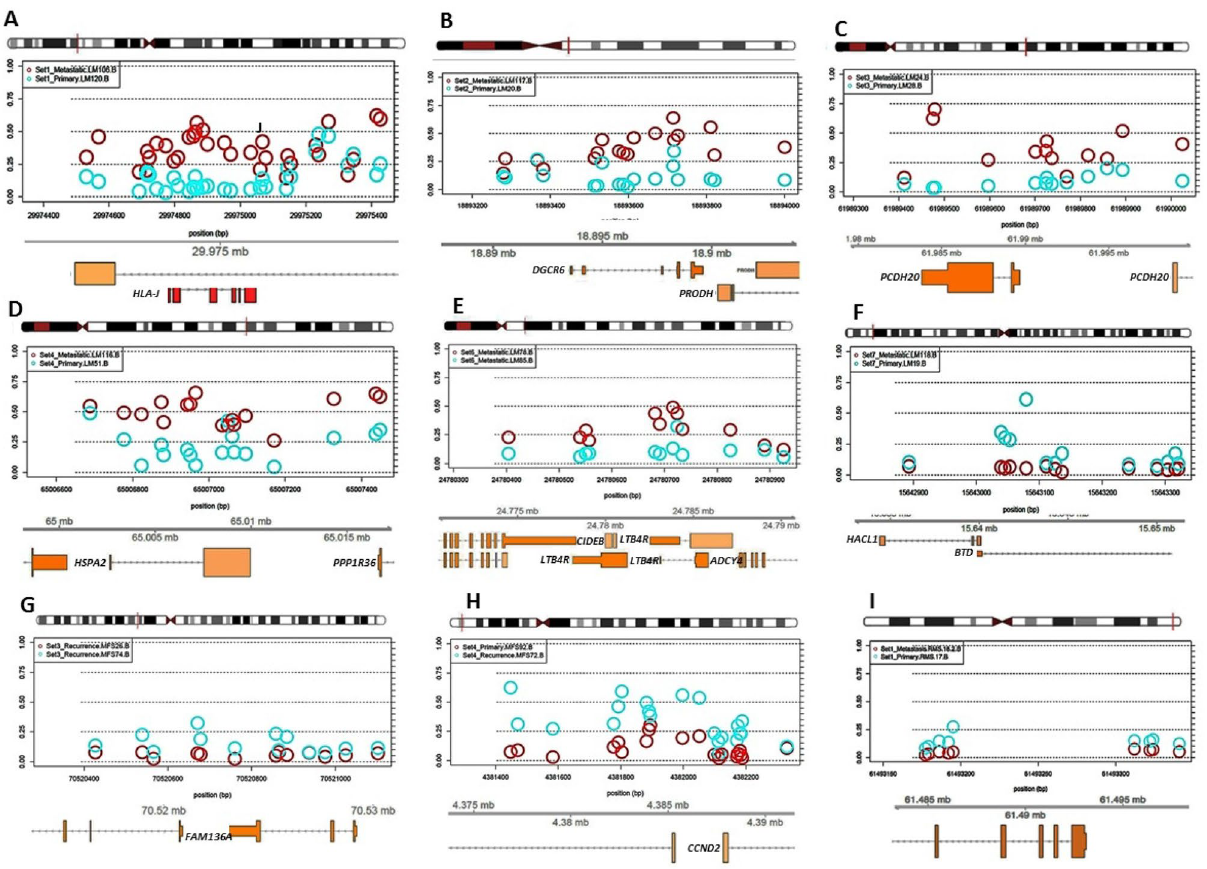
Figure 2. Beta values, probe distribution and genomic annotation for significant differentially methylated regions (DMRs) of selected paired samples. Leiomyosarcomas (LMS) sets 1 ( A : HLA-J in Chr 6 [897 bp region]), 2( B : DGRC6 & PRODH in Chr 22 [722 bp region]), 3( C : PCDH20 in Chr 13 [614 bp region]), 4( D : HSPA2 & PPP1R36 in Chr 14 [761 bp region]), 6( E : LTB4R & CIDEB in Chr 14 [523 bp region]) & 7( F : BTD & HACL1 in Chr 3 [429 bp region]). Beta values are plotted in blue (primary) and red (Metastatic: Mets). Set 6 ( E ) includes paired Mets (Mets1: red; Mets2: blue). Myxofibrosarcoma (MFS) sets 3 ( G : SNRPG & FAM136A in Chr 2 [675 bp region]) & 4( H : CCND2 in Chr 12 [884 bp region]). Sets 4 (primary red; Recurrence [Rec] blue); & set 3 (Rec1 red; Rec2 blue). Embryonal rhabdomyosarcoma ( I : Chr 20, 165 bp region; primary blue; Mets